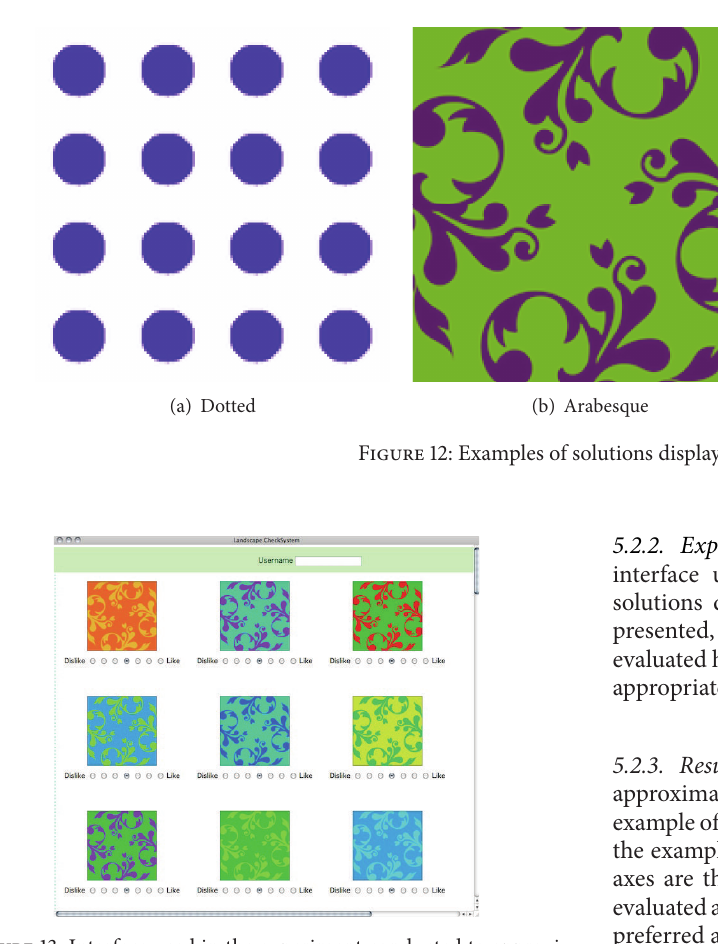
Figure 13: Interface used in the experiment conducted to approxi- mate the landscapes of participants.